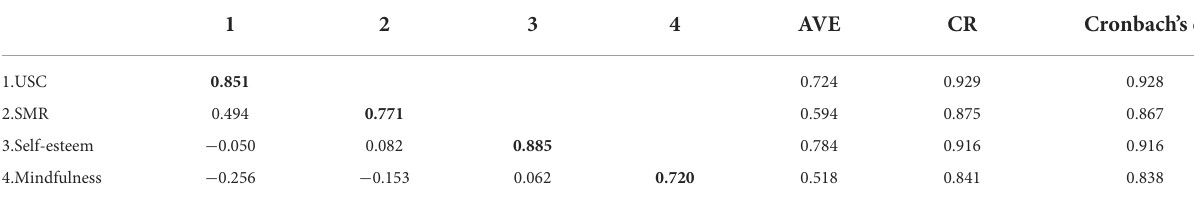
TABLE 2 Results of validity and